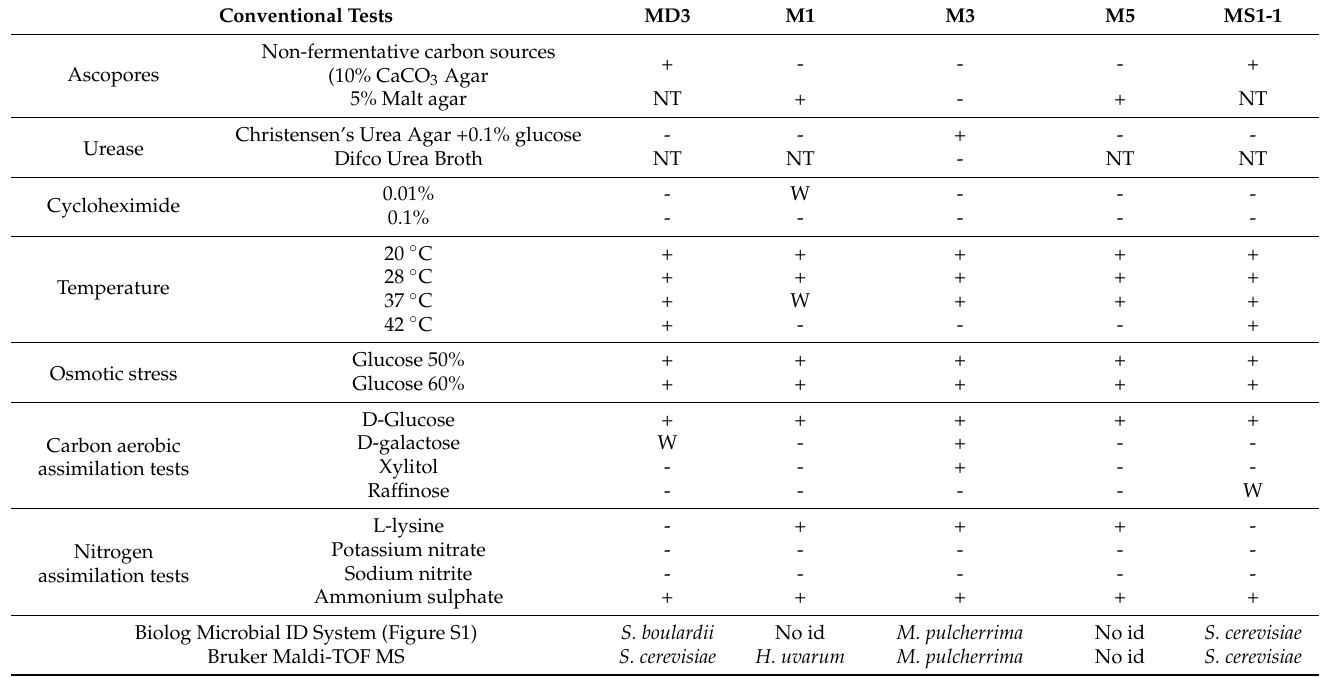
Table 1. Conventional test results obtained for yeasts isolated from wine wort and automatized taxonomical identification using the Biolog Microbial ID System and Bruker